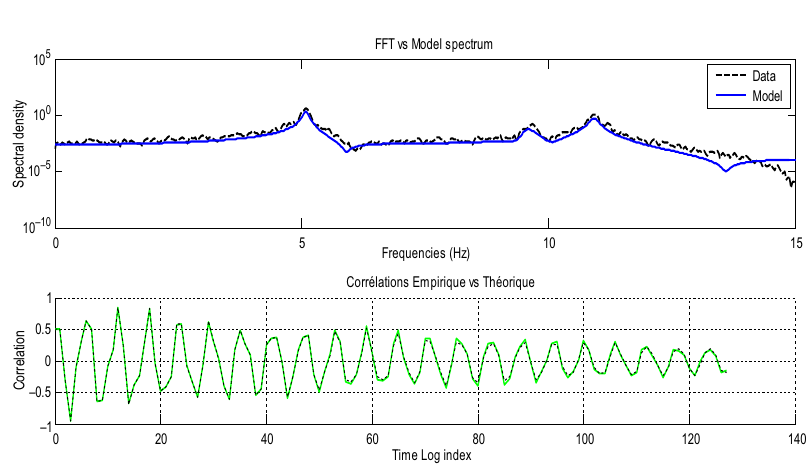
Fig. 9. Autospectrum sensor 3 of the Geiger dome